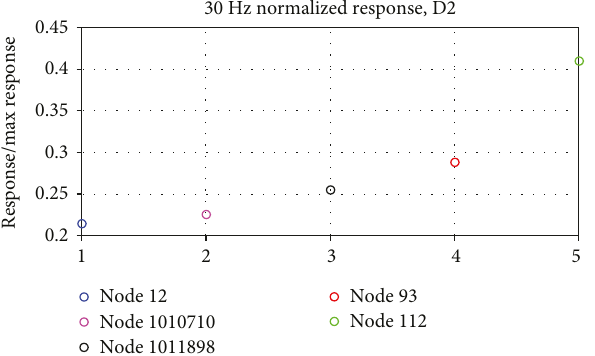
Figure 22: D2, 25 Hz normalized responses, double excitation tests.